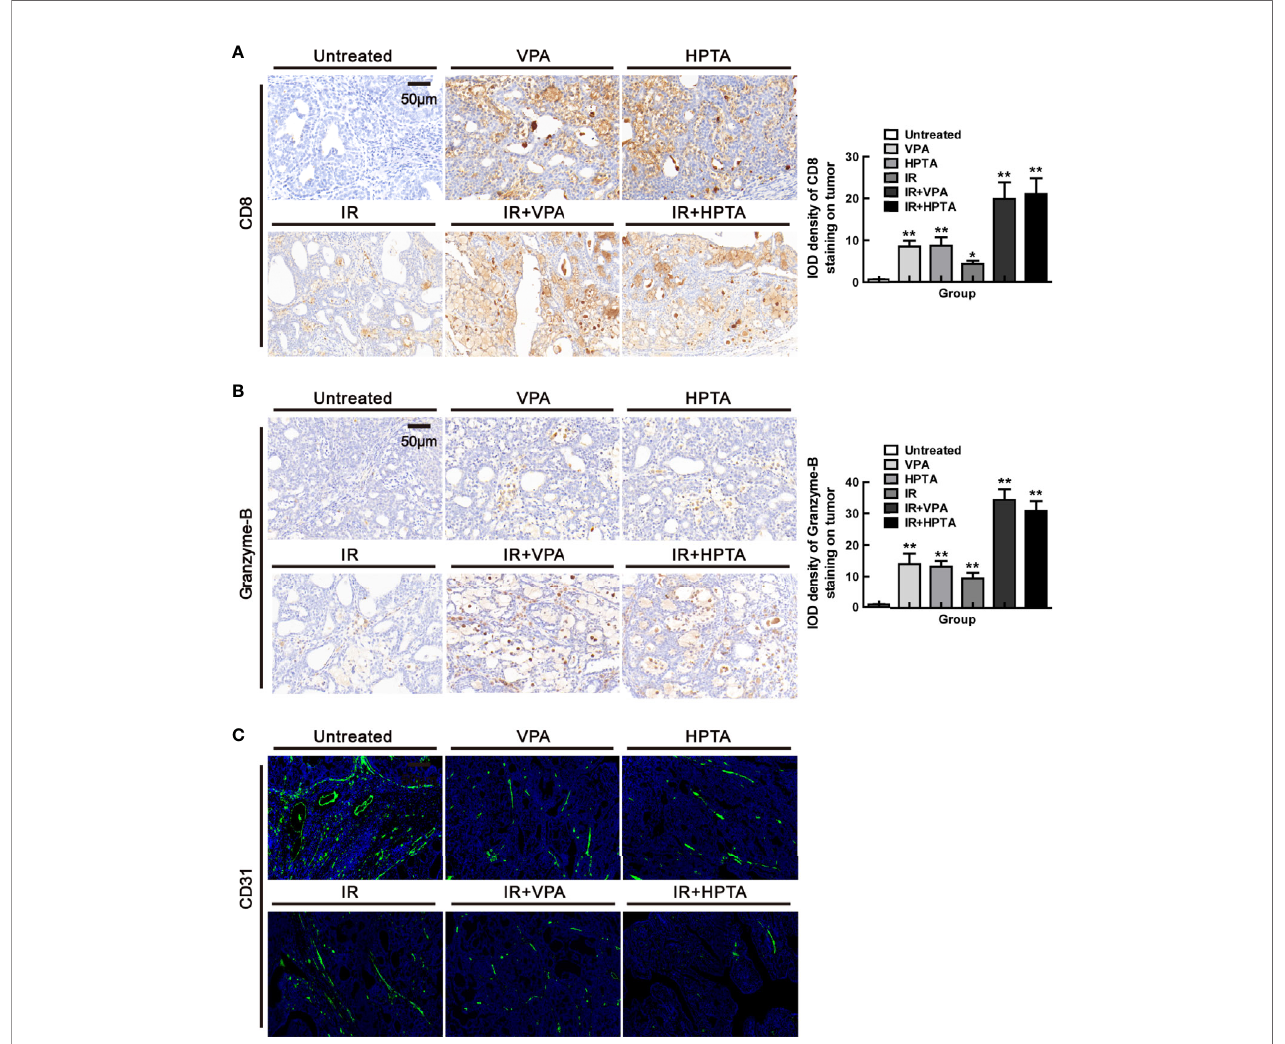
FIGURE 5 | VPA/HPTA reinforces the anti-tumor effect of radiotherapy by activating CD8+ T cell-dependent anti-tumor response and inducing vascular normalization in vivo at an early stage of the treatment. (A) IHC was performed on tumor sections for the marker CD8. Quantitation as a percentage of total tissue is shown to the right of representative images. (B) IHC was performed on tumor sections with the marker granzyme-B. Quantitation as a percentage of total tissue is shown to the right of representative images. (C) Immuno fl uorescence staining of tumor vessels (CD31+: green) and representative images are shown. Each data point in the graphs was from three independent experiments (mean ± SD). P -values were calculated by Student ’ s t-test (* P < 0.05, ** P <